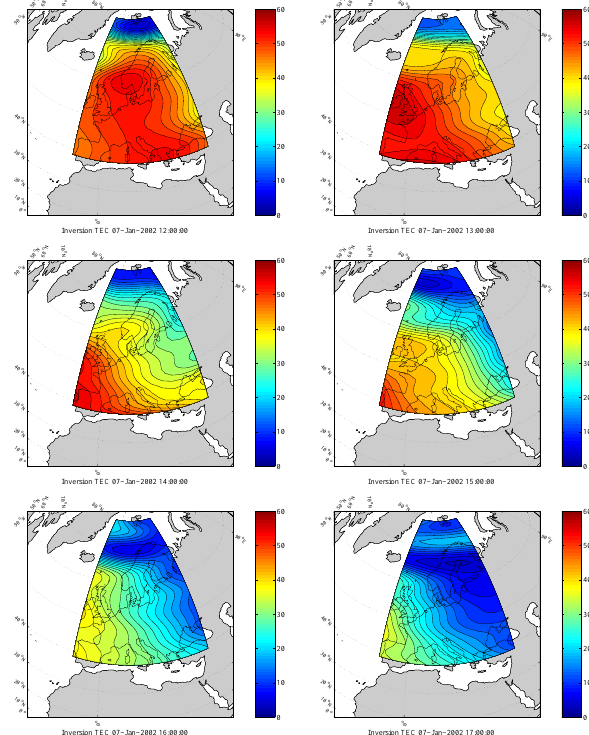
Fig. 4. Vertical TEC for each hour from 1200 to 1700 UT on 7 January 2002. Units are TEC units (10 16 electrons m − 3 )